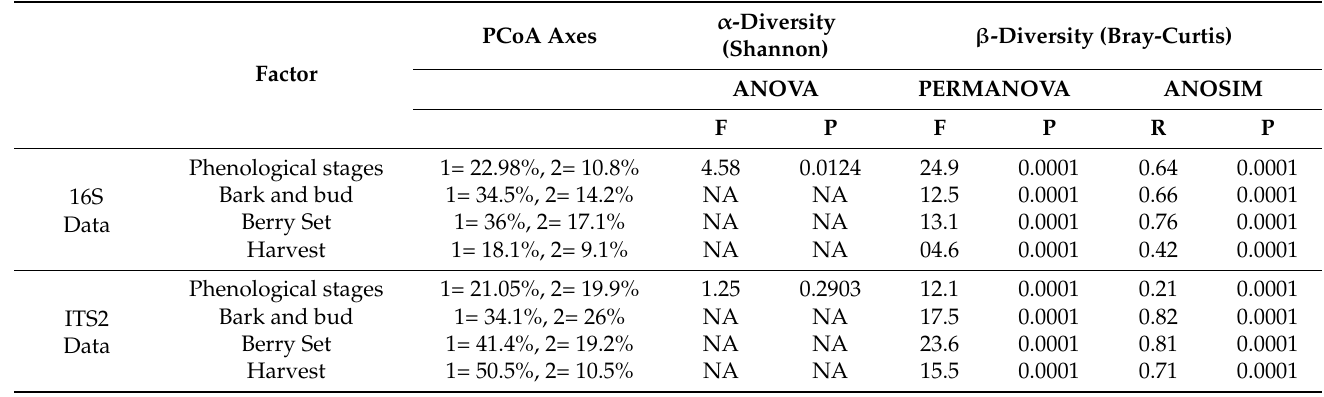
Table 3. Factors predicting α - and β -diversity on microbial communities in the